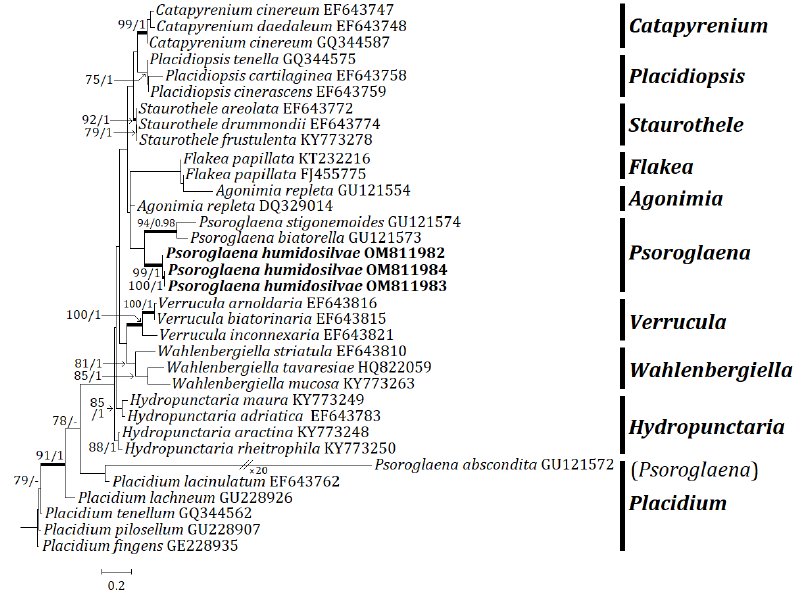
Figure 4. Phylogenetic relationships among available species in the genus Psoroglaena based on a maximum likelihood analysis of the dataset of LSU sequences. The tree was rooted with the sequences of the genus Placidium based on Muggia et al. [9]. Maximum likelihood bootstrap values ≥70% and posterior probabilities ≥95% are shown above internal branches. Branches with bootstrap values ≥90% are shown as fatty lines. The new species, P. humidosilvae , is presented in bold as their DNA sequences were produced from this study. All species names are followed by the GenBank accession numbers.